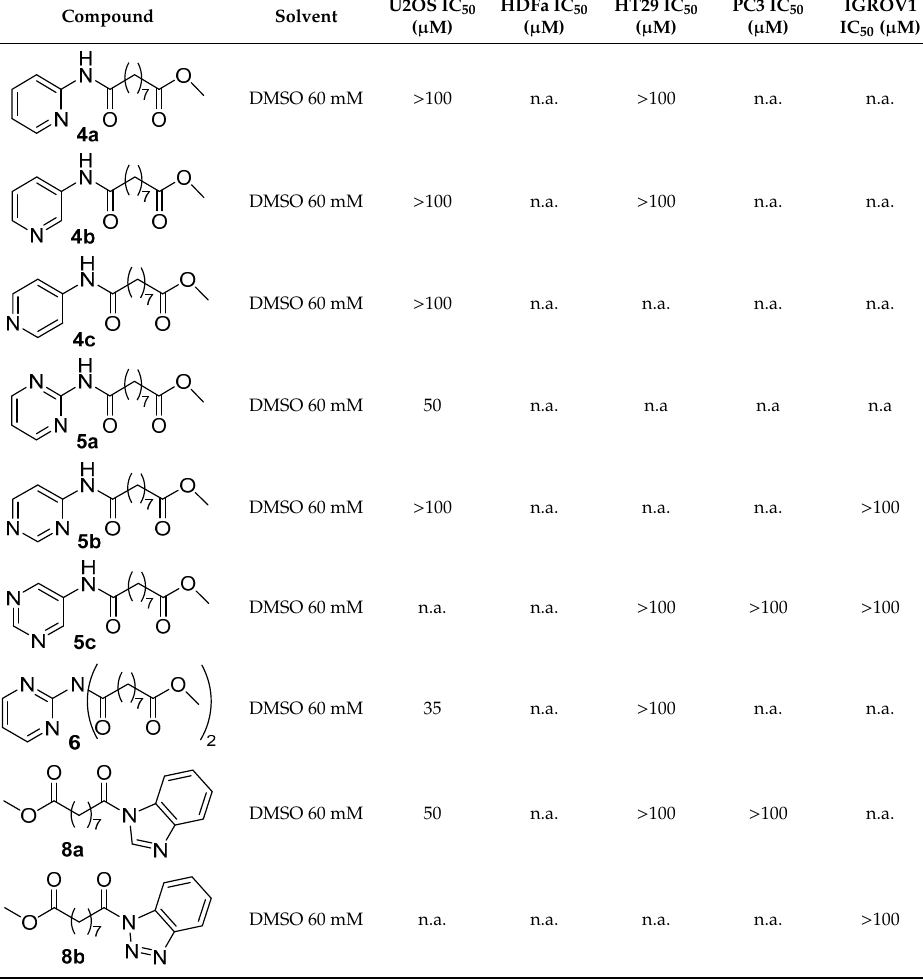
Table 1. Half maximal inhibitory concentration (IC 50 ) of compounds in different cell lines after 48 h of treatment ( μ M). (n.a. = non active; DMSO = dimethyl sulfoxide). Compound